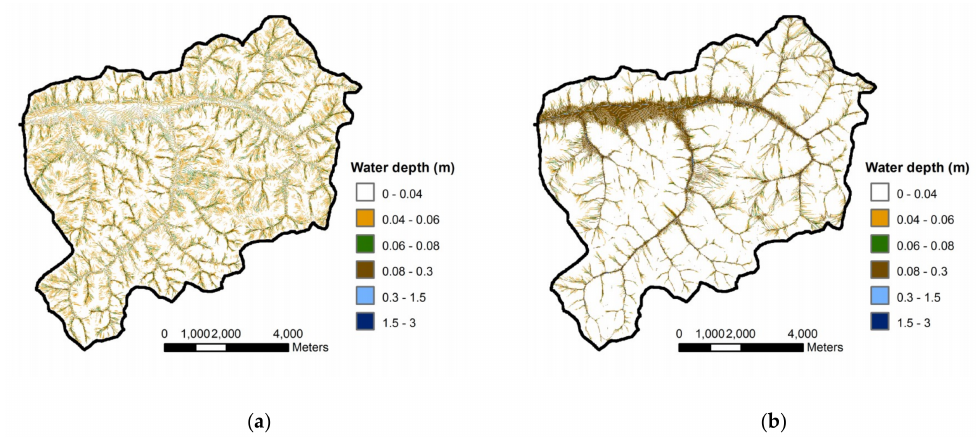
Figure 6. Distribution of the water depths during the simulation of the storm occurring on 16 August 1968, ( a ) 2nd hour, ( b ) 20th hour.